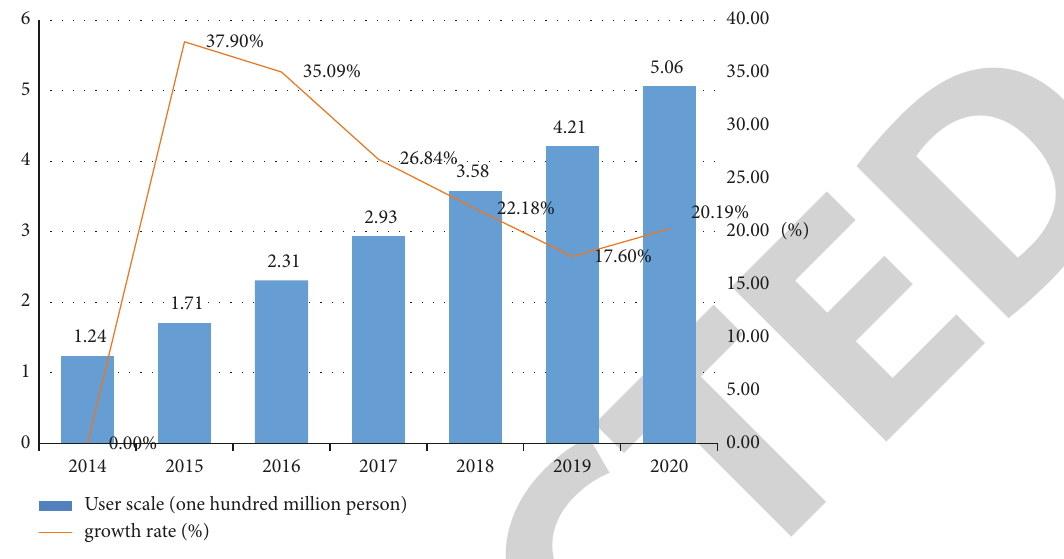
Figure 3: The chart of scale and growth rate of China’s JIT distribution users from 2014 to 2020.